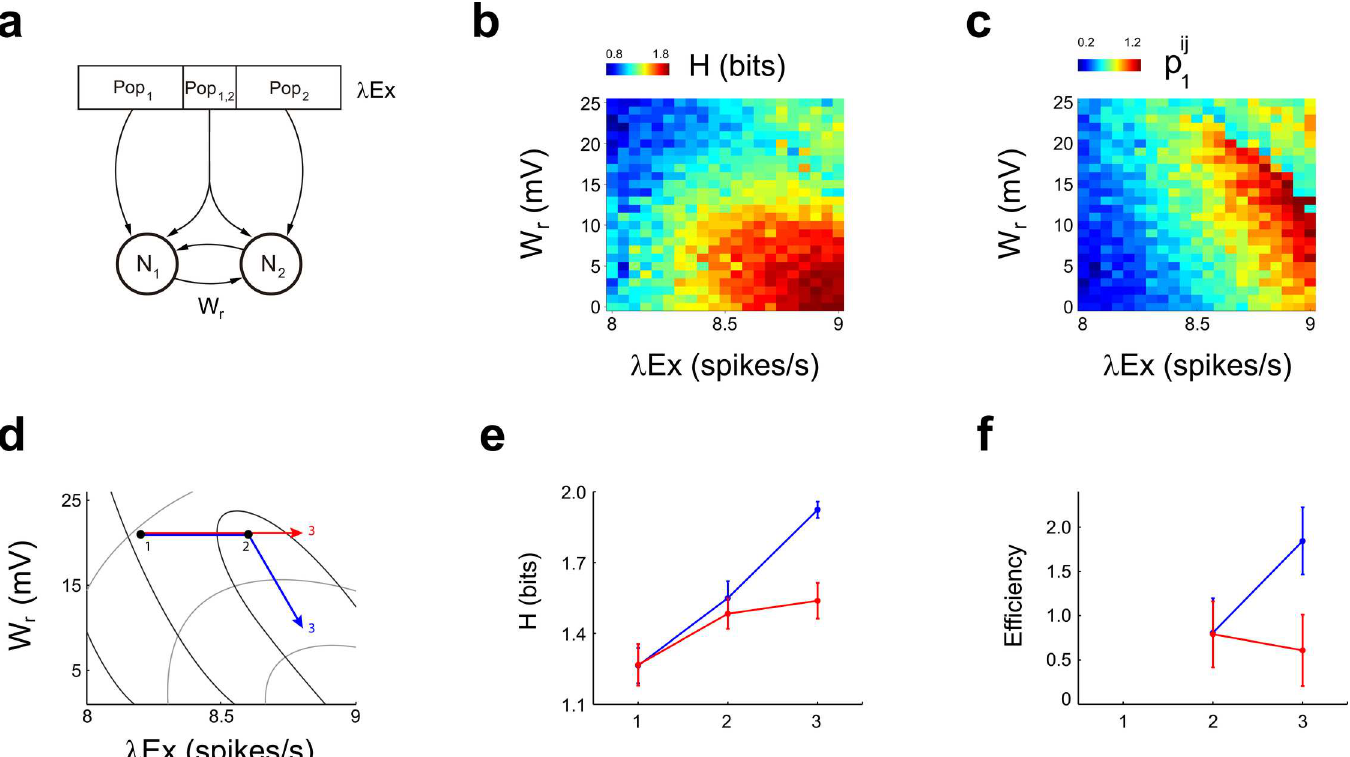
Fig 4. Entropy and p ij in a LIF model. a , Scheme of a leaky integrate-and-fire model composed of two neuronswith intrinsic and extrinsic connections. 1 NeuronsN1 and N2 receiveinputs from an afferent populationof 400 excitatory and 100 inhibitoryneurons, which containsan exclusivepopulation(Pob 1 and Pob 2 projectingto neuronsN1 and N2 respectively) and a common populations(Pob c ) where each afferent excitatory and inhibitoryneuronprojects both to N1 and N2. Moreover, neuronsN1 and N2 are reciprocallyconnectedthrough an excitatory synaptic weight W r . b-c , Effect of changingthe mean firing rate of the excitatory afferent population( λ Ex) and W r in the entropy (b) and p ij (c). An increment in λ Ex and W r causes a significantrise in entropy, while p ij remains 1 1 constant if λ Ex is increasedwhile decreasing W r at the same time. d , A trajectory in (W r , λ Ex) space that allows to increase entropy efficiently is depictedas a blue arrow. The red arrow implies increments in λ Ex only. Light and dark grey lines represent level curves for constant entropy and constant p ij respectively.A 1 simultaneous increment in efficiency and entropy requiresincreasing λ Ex whilereducingW r in such a way that the changein p 1 tends to zero. e-f , Efficiency and entropy for points 1, 2 and 3 of trajectories shown in (d). Efficiency increasesfor the blue trajectory, and decreases for the red trajectory. All comparisons within trajectories are significantly different (N = 30 repetitions, P < 1x10 -3 , sign test).